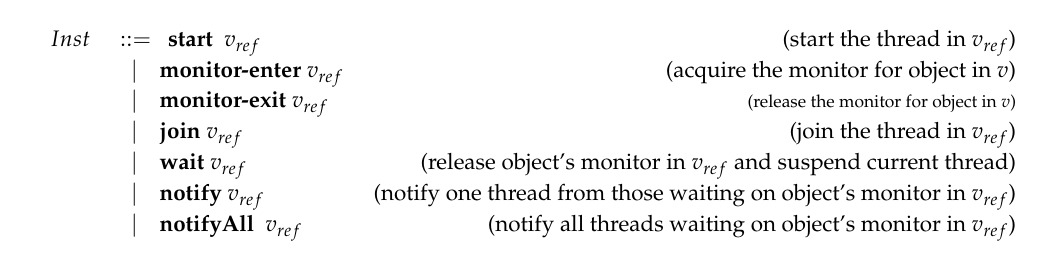
Table 6. Smali + : concurrent